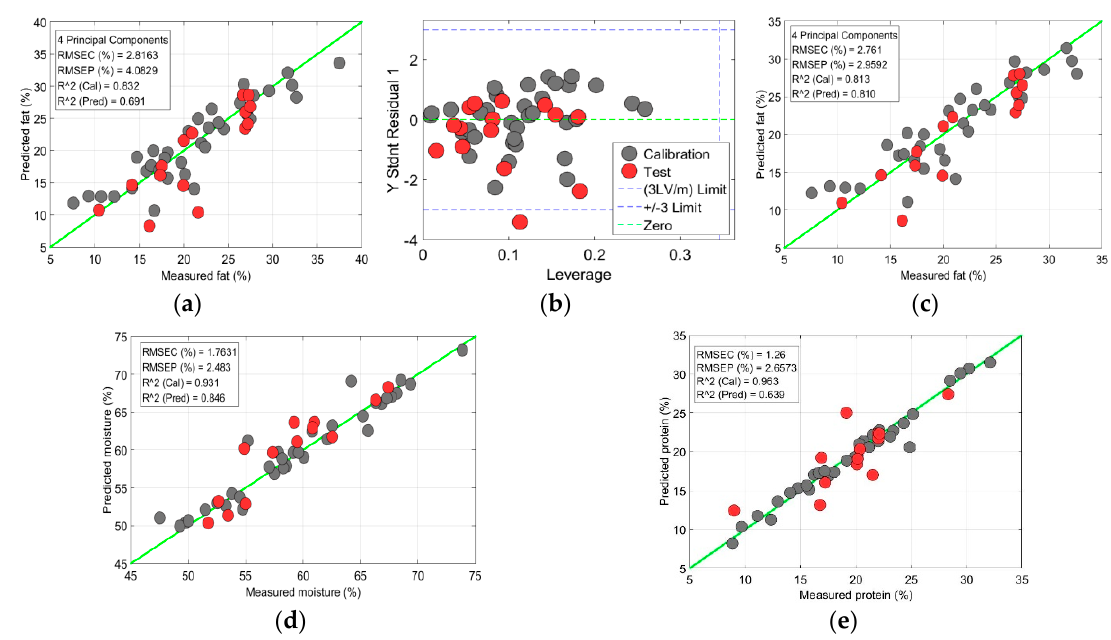
10 Figure 7. Counter-plot example obtained from the grid-searching method for optimizing the support- vector regression (SVR) parameters. The arrow indicates a finer grid with the lowest RMSE with the highest prediction. 3.4. Chemical Component Prediction Once the parameters were optimized for both the PLSR and SVR models, the optimized parameters with the lowest RMSC were used to predict the chemical components of the meat samples. In this study, the prediction model for the meat data was also contaminated by the outliers; it was perhaps caused by a wrong system response, variability in the measurements, or experimental error. Therefore, identifying and excluding outliers from the data is significant, to prevent false data predictions. To detect outliers in the data, a widely used 3 σ rule was applied, by removing values exceeding ±3 σ [31,32]. Figure 8 presents an example of the outliers’ impact on the fat-prediction accuracy in the sirloin samples. For the fat prediction, the calibration data exhibited a strong correlation and a low error rate ( 𝑅 (cid:2870) c : 0.83; RMSEC: 2.81%) between the measured and predicted values (Figure 8a). However, for the prediction data set, the correlation value decreased and the model error increased ( R (cid:2870) p : 0.69; RMSEC: 4.08%), due to the presence of outliers in the data. The outliers were identified by observing the leverage values against the standard residual values (Figure 8b), where some data surpassed the limit of ±3 σ ; they were considered outliers and excluded. After excluding outliers from the data, the prediction accuracy was improved with 𝑅 (cid:2870) p of 0.81 and RMSEC: 2.95% (Figure 8c). A similar method was used for outlier detection in the other samples and